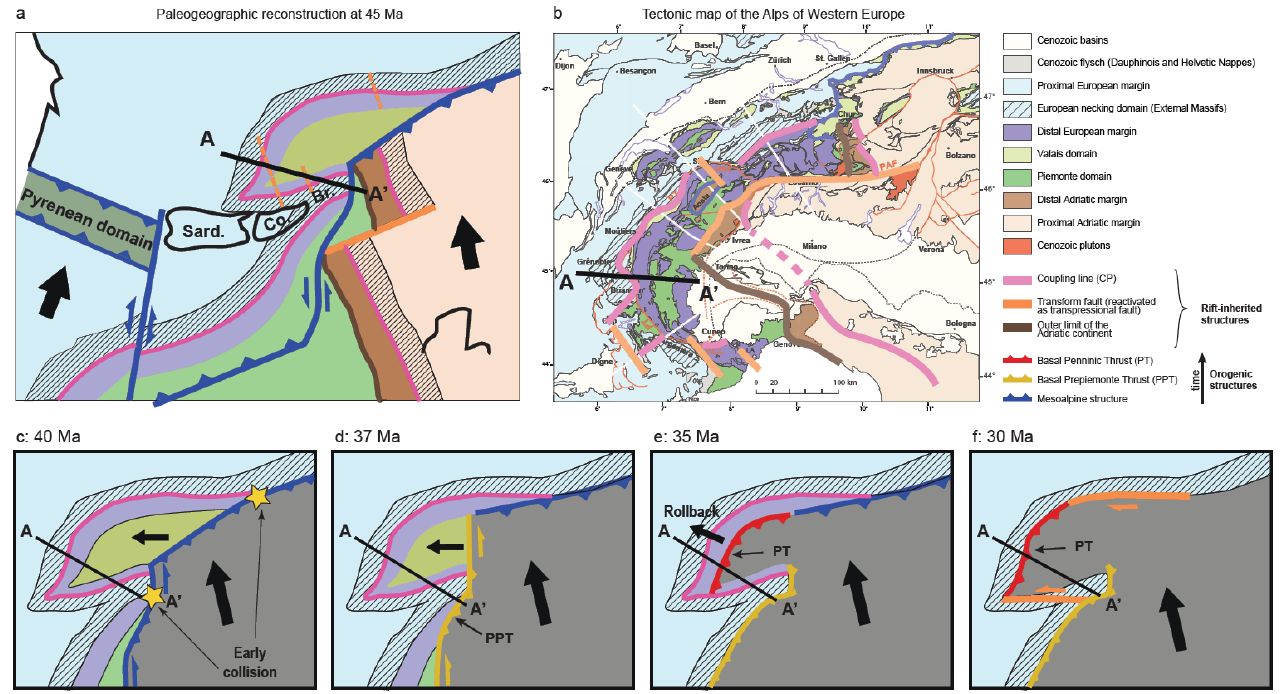
Figure 12. ( a ) Schematic paleogeographic restoration of the Alpine Tethys realm at 45 Ma based on ( b ) a present-day tectonic map of the Alps of Western Europe (modified from [24]; see text for details); ( c – f ) Schematic paleogeographic restorations of the Briançonnais region showing the successive phases of continental collision, Basal Prepiemonte Thrust (PPT) and Basal Penninic Thrust (PT) activity, as well as the local vs. regional kinematic directions (see text for details and discussion).